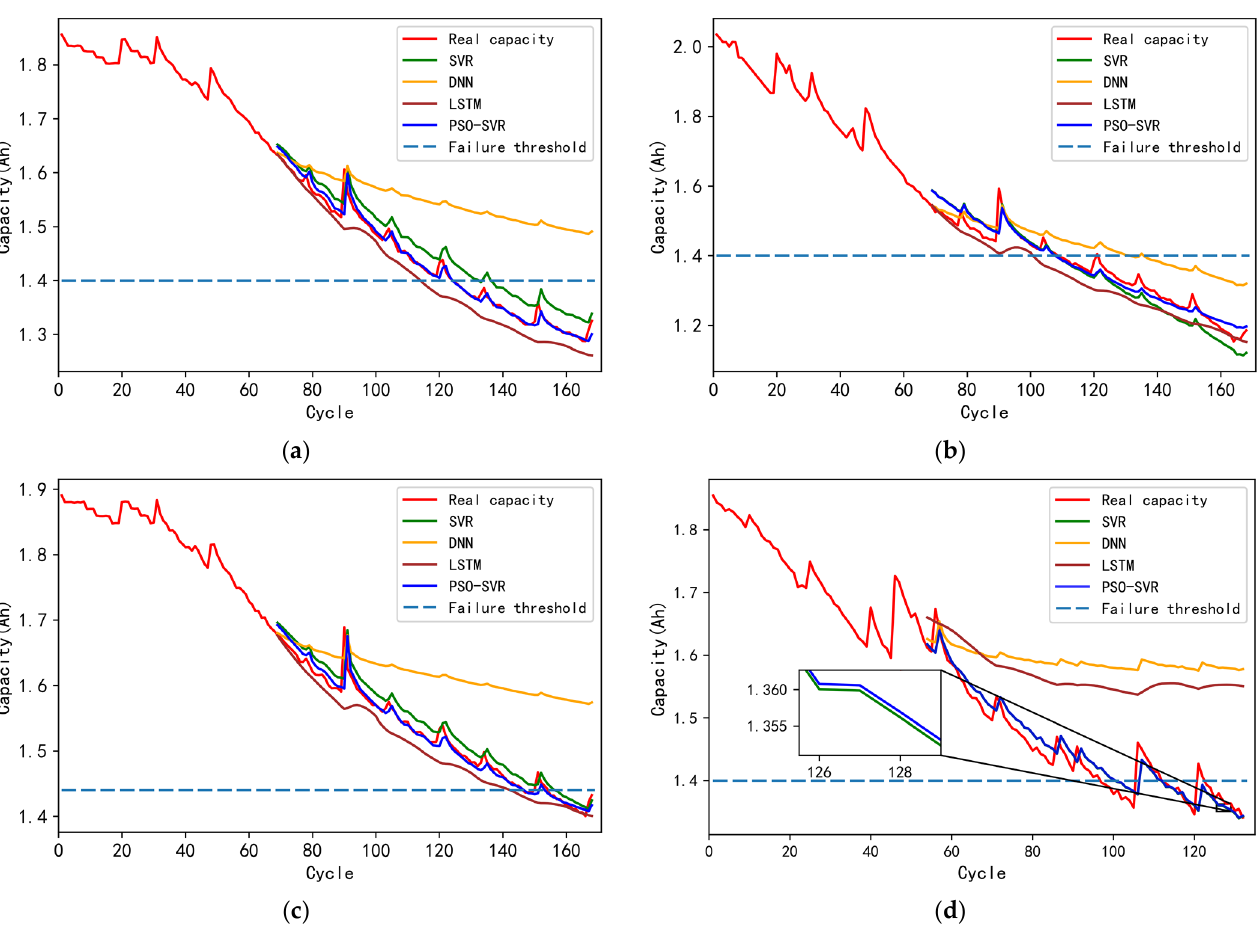
Figure 6. Prediction results based on SVR, DNN, LSTM and PSO–SVR using the first 40% of the total cycle data for training: ( a ) B5; ( b ) B6; ( c ) B7; ( d )